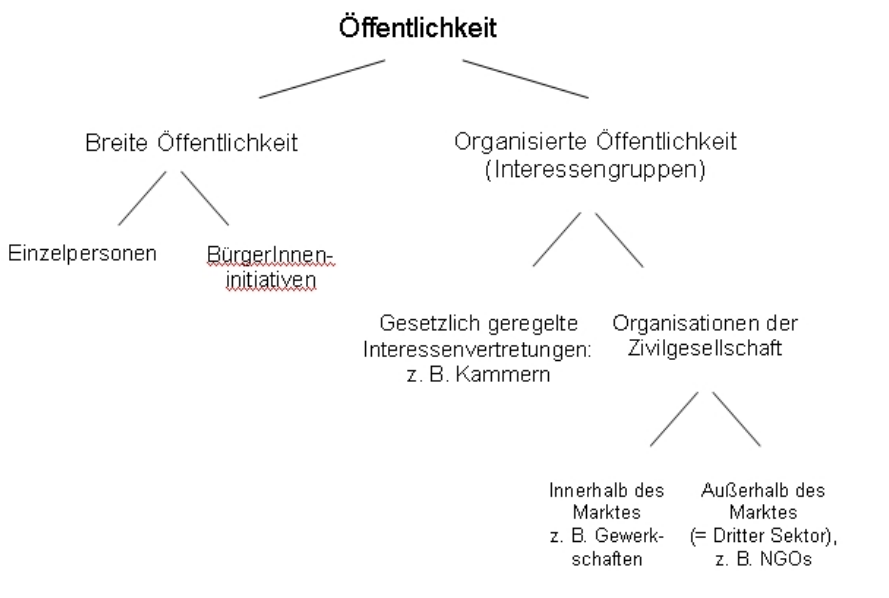
Figure 1: "Typen der Öffentlichkeit", in Anlehnung an: Europäische Kommission 2002, S. 6. Grafik: Arbter, K. (Arbter & Trattnigg, 2005)